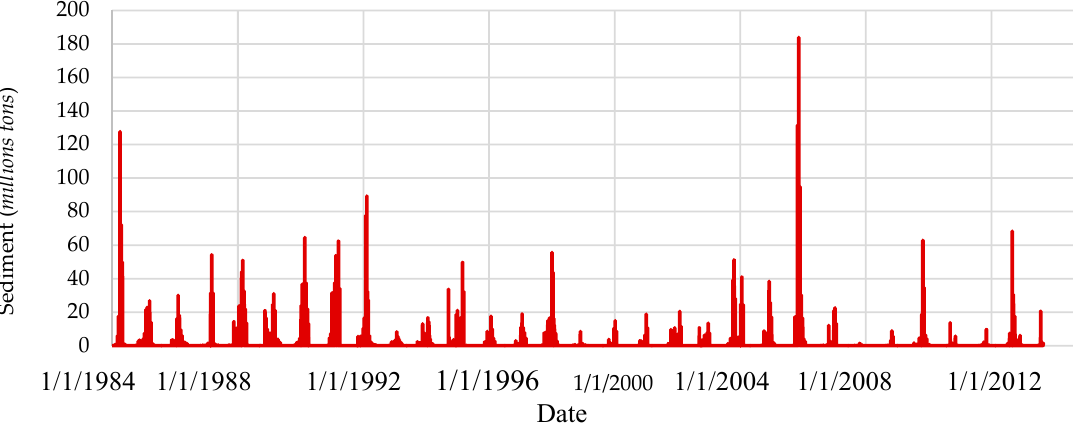
Figure 11. Simulated sediment inflow into the Hemrin Reservoir.